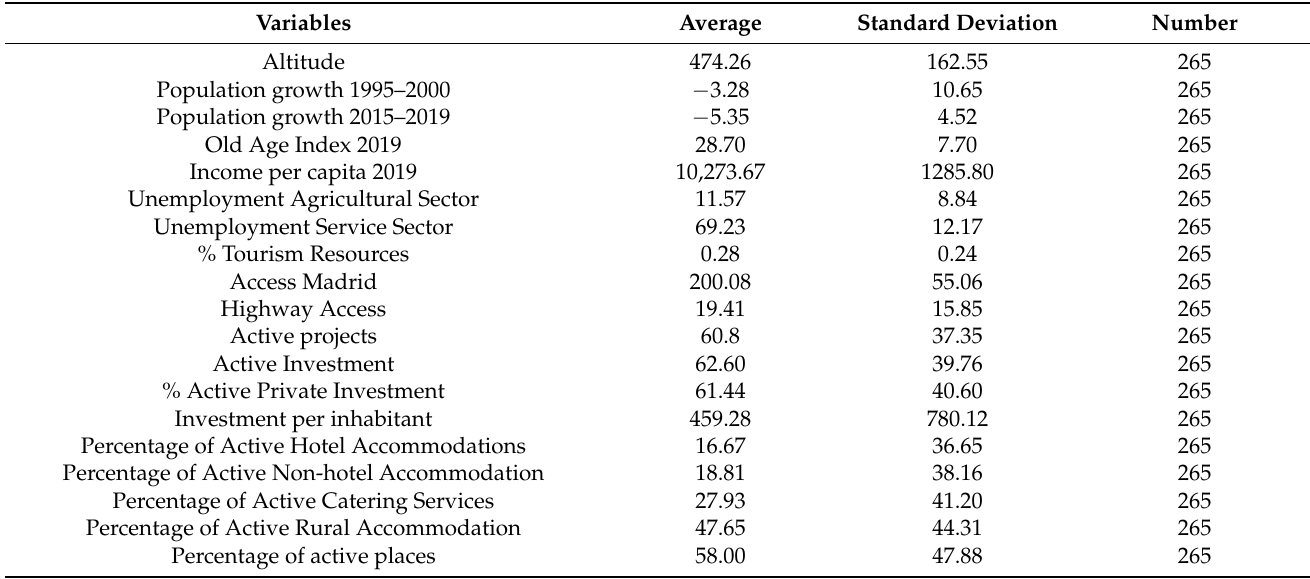
Table 3. Statistical